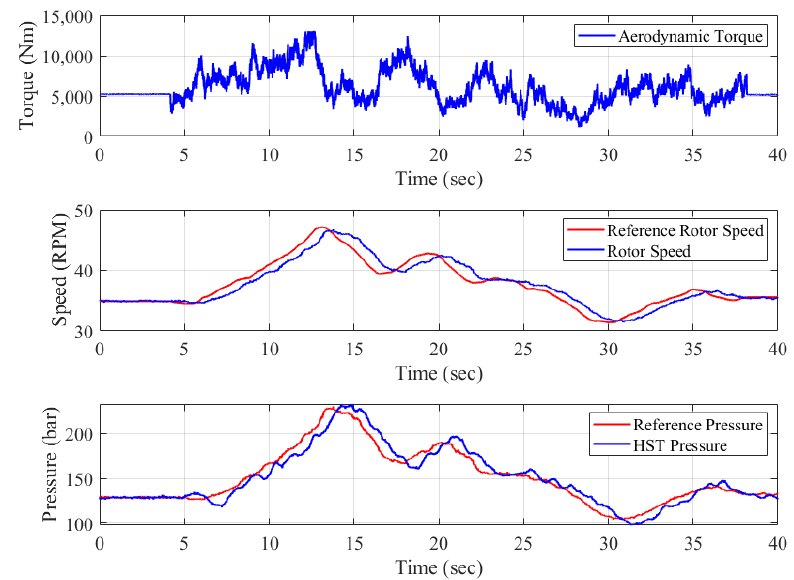
Figure 9. Performance of the HST wind turbine to a turbulent wind.